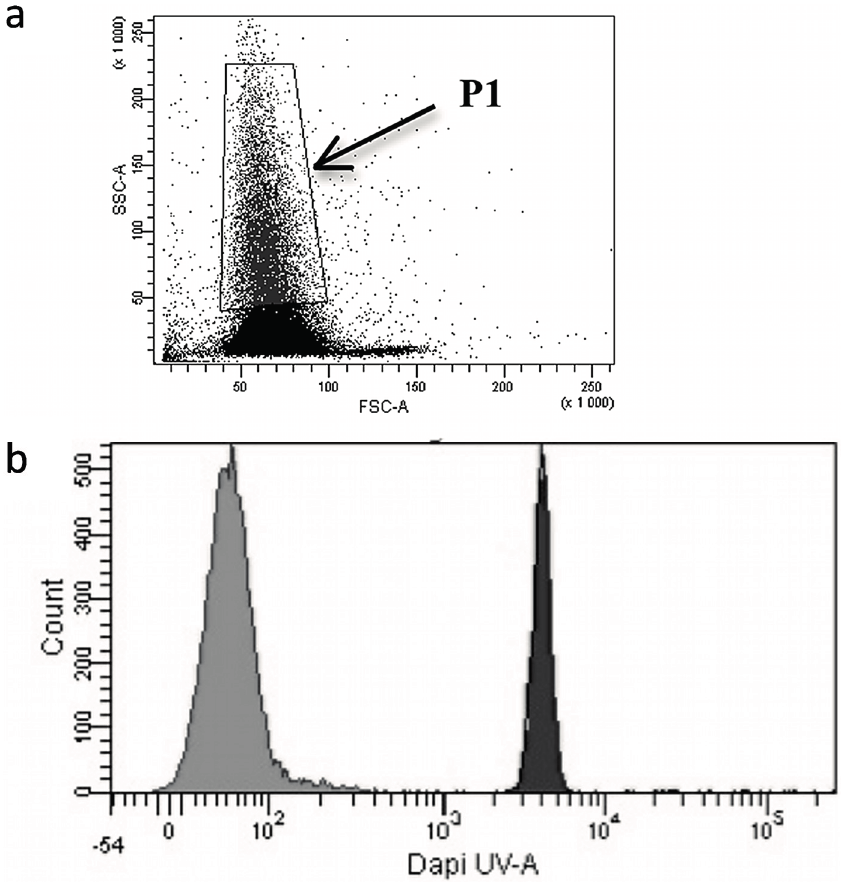
Figure 2. B a P uptake in trout erythrocytes analyzed by flow cytometry. ( a ) Flow cytometry (FCM) profile of trout erythrocytes. The gate contained the point-cloud profile of erythrocytes in control cells. Cell size is expressed by forward scatter = FSC-A ( x -axis), and intracellular structure complexity is expressed by side scatter = SSC-A ( y -axis). ( b ) Profile of B a P-treated trout erythrocytes in primary cultures. B a P was naturally fluorescent in UV. Grey histogram: FCM fluorescence profile for control cells and/or 0.1% DMSO control. Black histogram: FCM fluorescence profile of trout erythrocytes treated with 10 μ M B a P for 1.5 h. FU: Fluorescence Unit ( x -axis), with cell numbers on the y